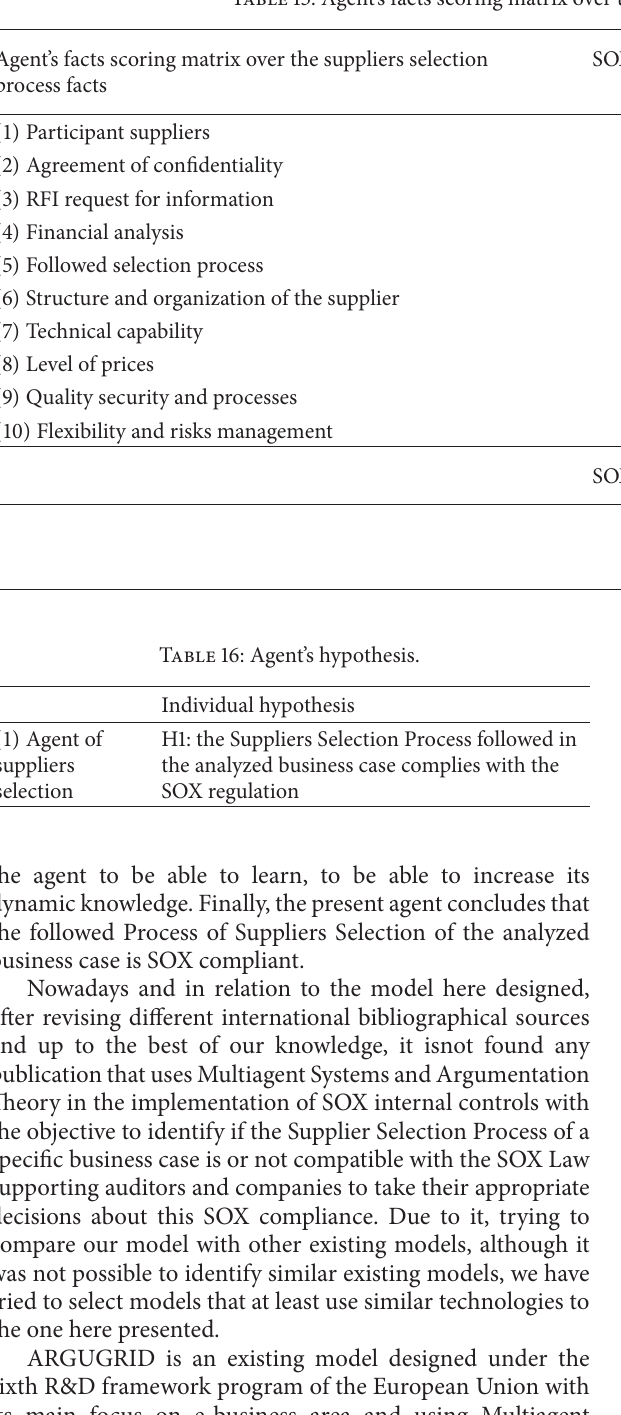
Table 15: Agent’s facts scoring matrix over the business case facts based on its beliefs.